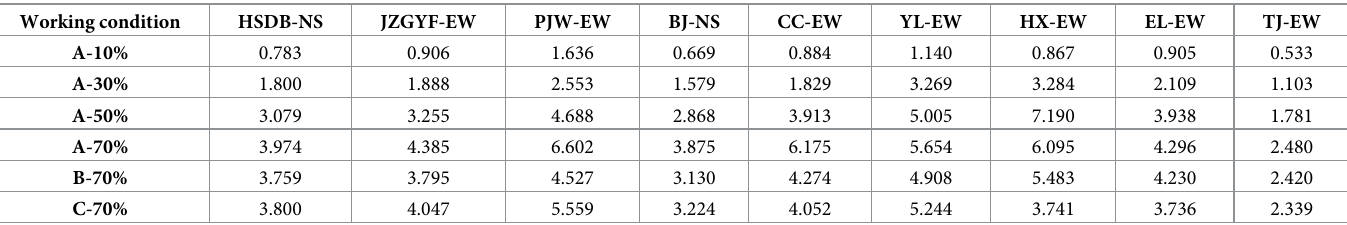
Table 14. The maximum hydrodynamic pressure P WD , y of the whole tank under unidirectional secondary seismic motion with 1.0 m/s 2 peak acceleration (KPa). Working condition